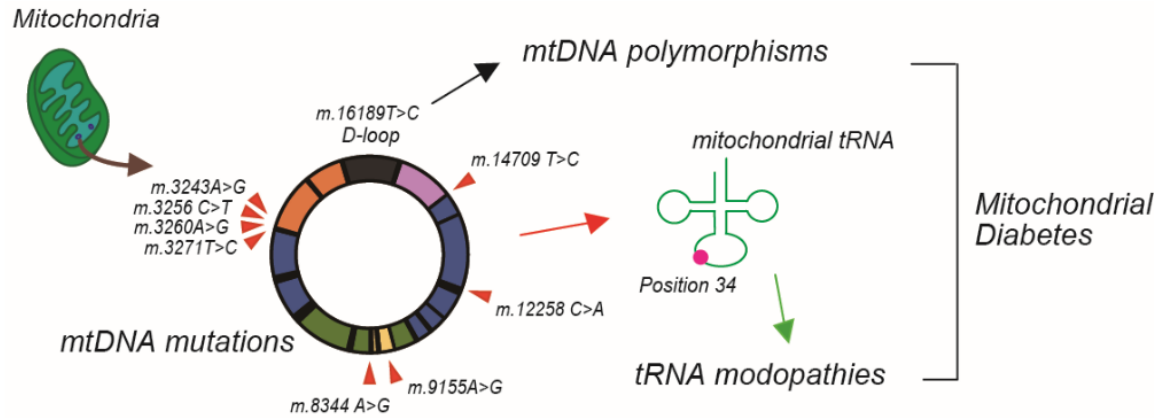
Figure 2. Mitochondrial diabetes-related mitochondrial DNA mutations.